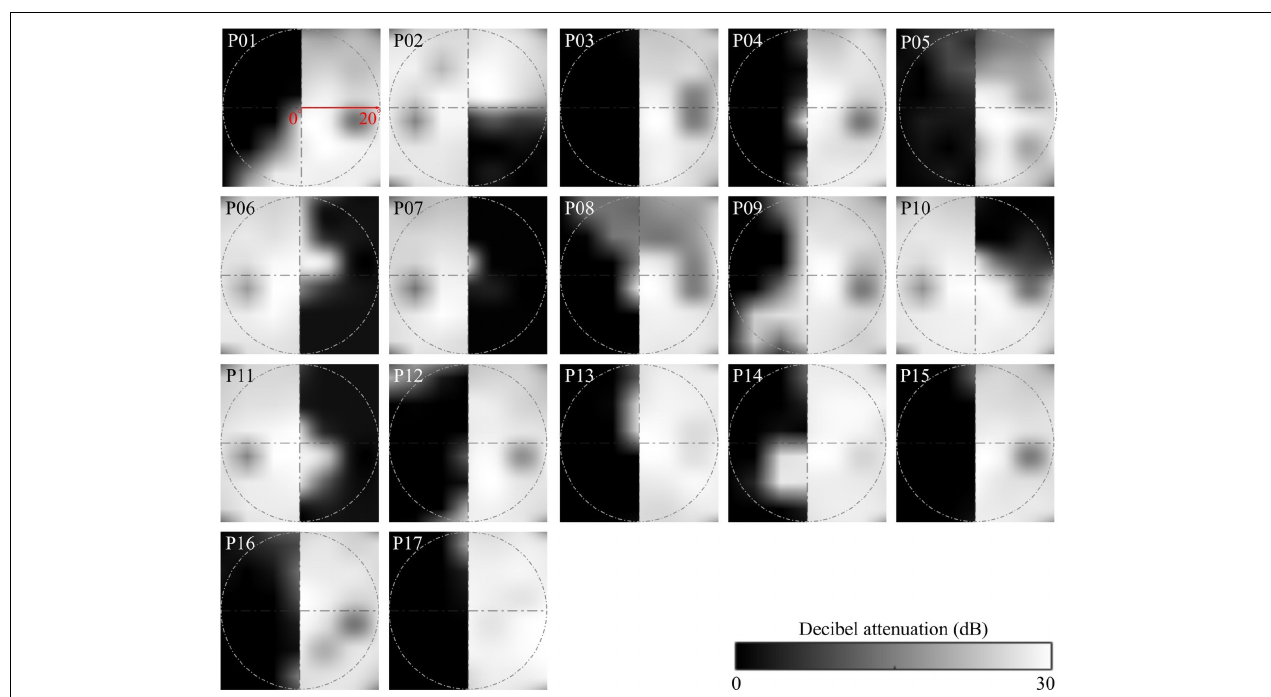
FIGURE 1 | Visual field maps of the OCL participants. We used central 30-2 threshold Humphrey perimetry. Maps show averaged sensitivity of left and right eyes. OCL participants’ VFDs are, as a rule, limited to one hemifield, due to the damage caused by contralateral post-chiasmatic or V1 lesions. Each panel shows the measured VFD of one participant interpolated on a 256 × 256 pixel grid representing a visual extent of 20 ◦ radius corresponding to the dimensions of our scene images (see P01). Luminance sensitivity is given by decibels of attenuation of the target, shown in the grayscale. No attenuation of light intensity is marked as 0 dB, which indicates that the participant was not able to detect the stimulus at the highest luminance.